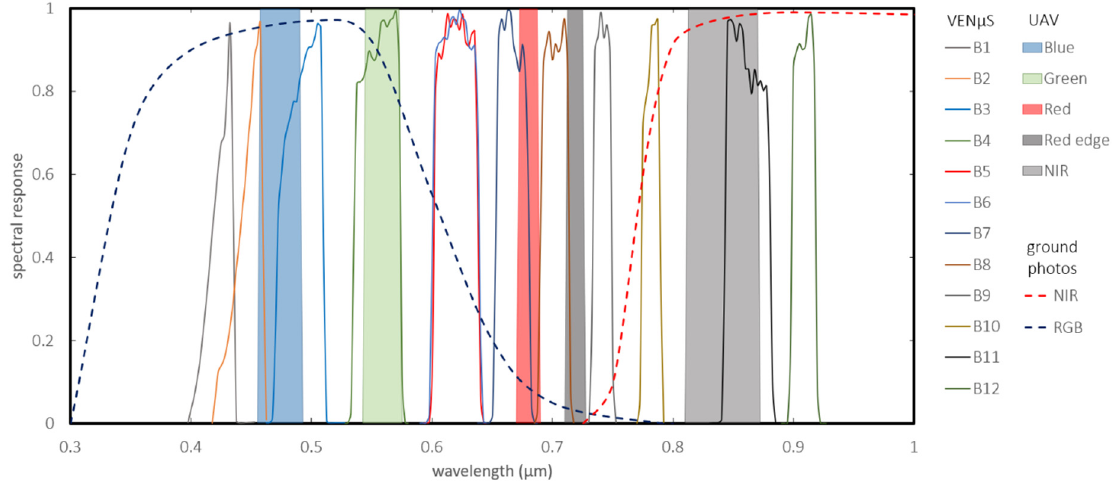
Figure 2. The spectral bands of the three sensors: UAV (16 bit), VEN μ S (16 bit), and ground photos (8 bit).